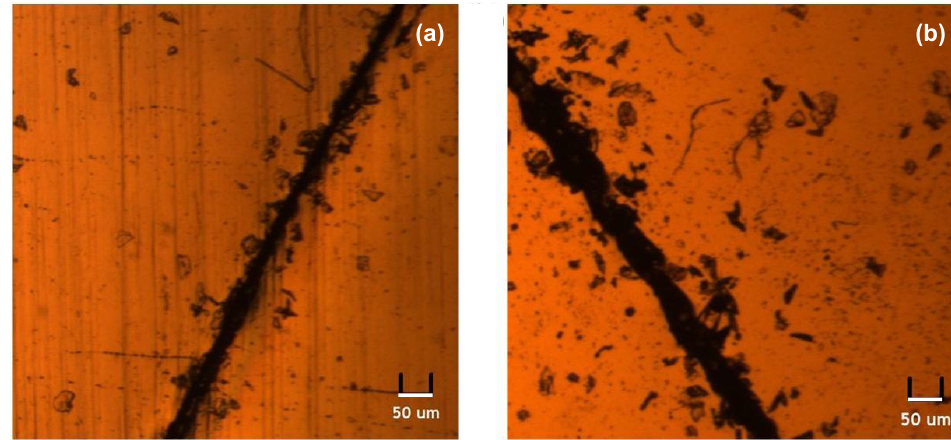
Figure 5. Microscopic images of ( a ) MDI-P1000, ( b ) TDI-P1000.